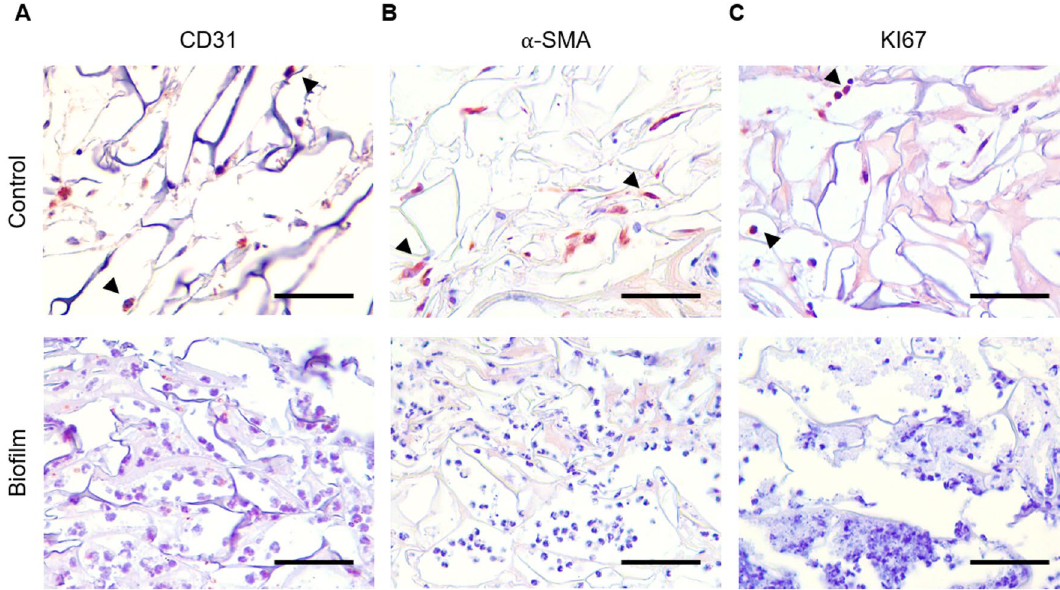
Figure 8. Regeneration parameters in vivo. Histological sections from biofilm-containing or control scaffolds after ten days of implantation were processed for immunohistochemistry with specific antibodies and a qualitative assay was performed. ( A ) Endothelial cells as an indicator of angiogenesis analyzed with CD31. ( B ) Activation of fibroblasts in the wound site analyzed with α-SMA antibody. ( C ) Cell proliferation analyzed with KI67 antibody. Positive stained cells are indicated with arrow heads. Scale bar represents 60